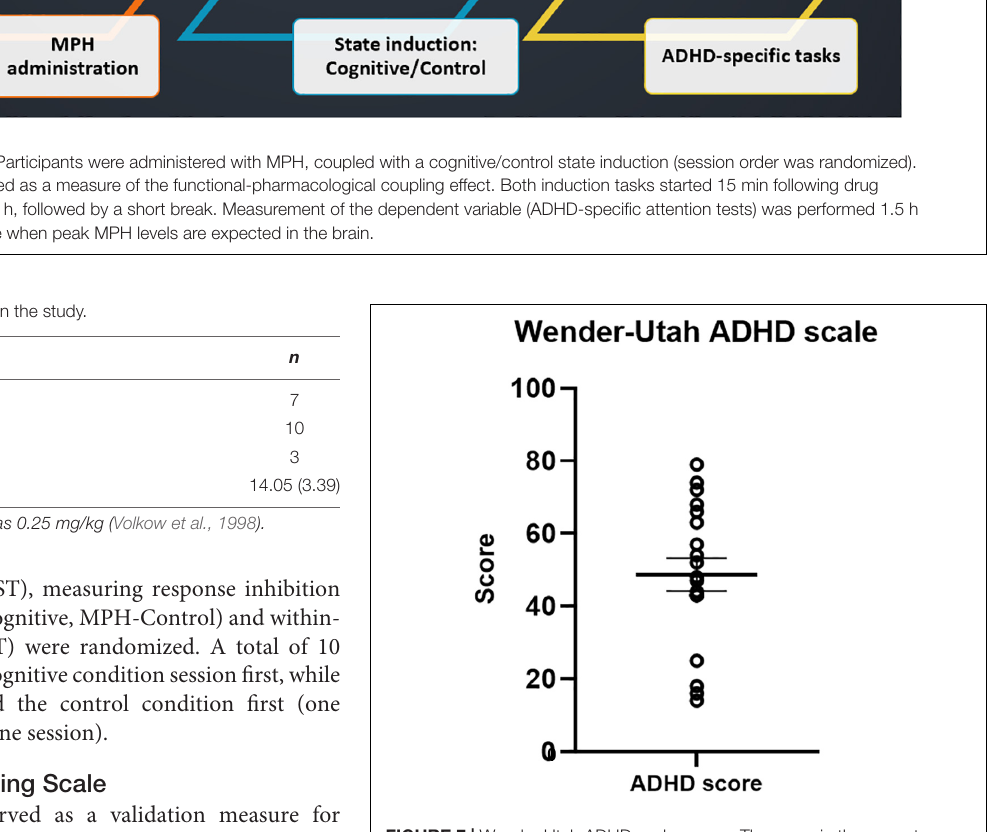
FIGURE 7 | Wender-Utah ADHD scale scores. The mean in the current sample was 50. 76 – higher than a cut-off score of 46, previously found to identify 86% of ADHD-diagnosed adults (Wender et al.,